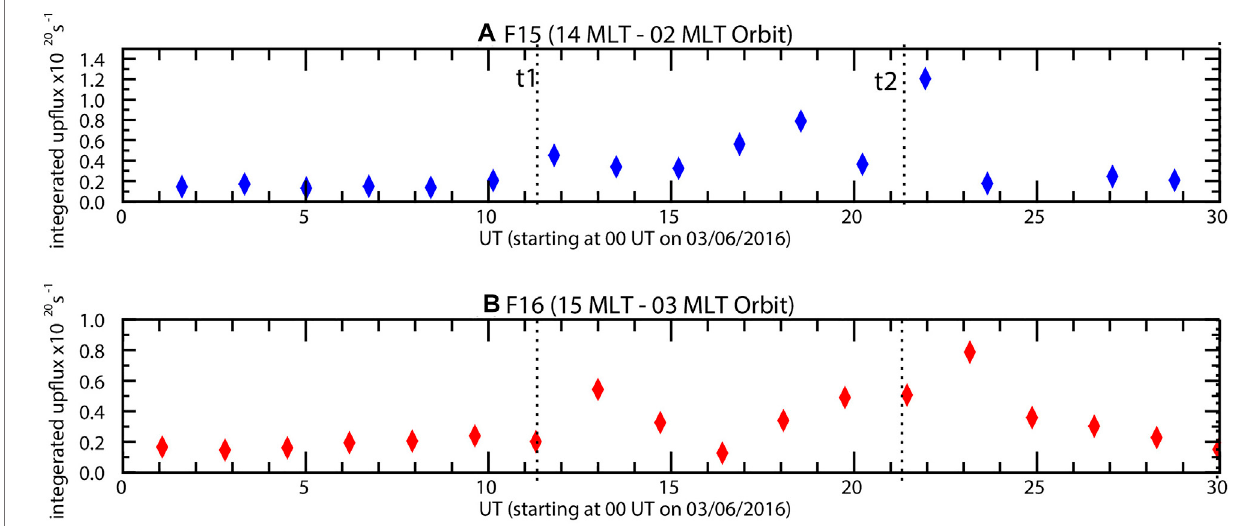
FIGURE12| Theupward fl uxesintheNorthernHemisphereforDMSPF15andF16satelliteswereintegratedalongthetrajectorieswhenthesatellitewaspoleward of 45 ° mlat and assuming a unit length in the cross-track direction. The upward fl ux values were normalized to 1 × 10 20 s − 1 . DMSP F15 pass at ∼ 01:16 UT on March 07 was not included due to large data